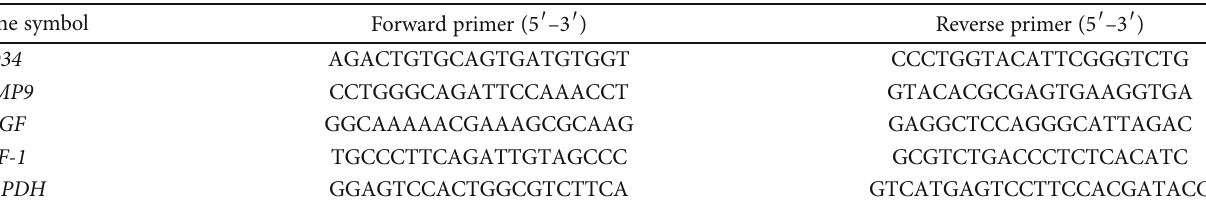
Table 1: Sequences of primers for